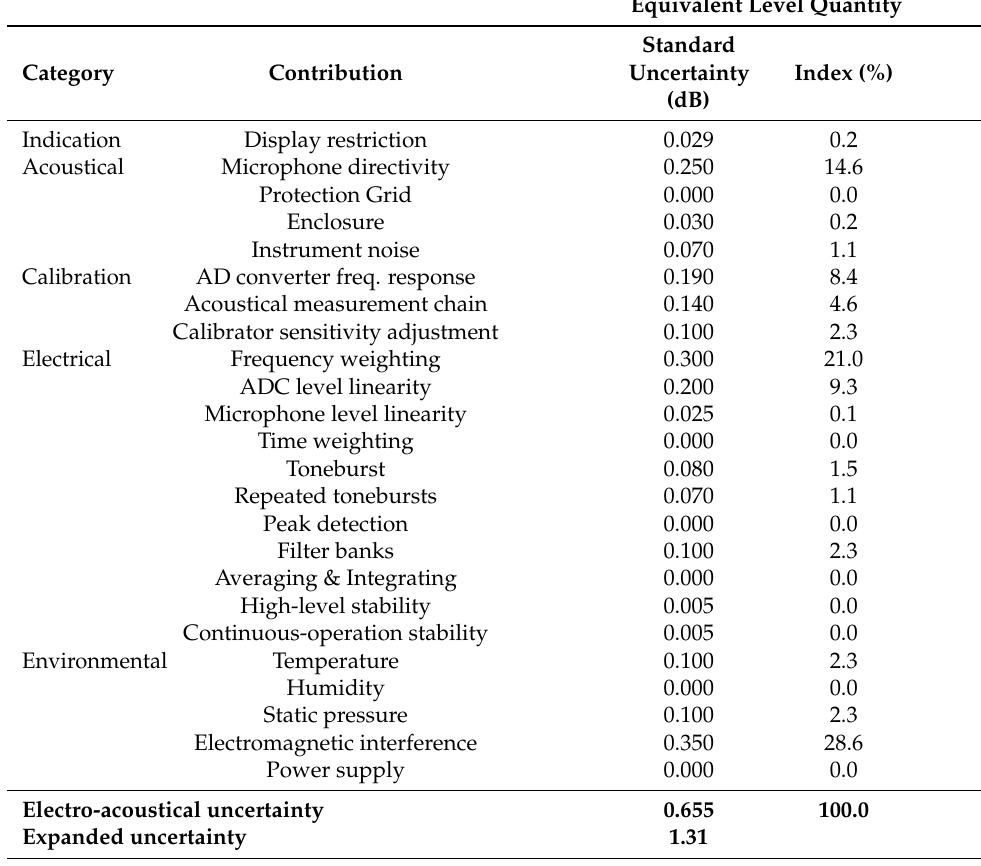
Table 5. Contributions to the electro-acoustical uncertainty as computed based on the tests completed with the current version of the prototype and estimated with reference to the uncertainty budget of the USPM